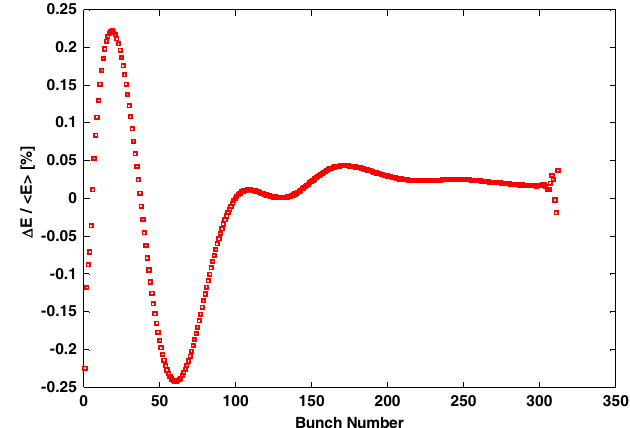
FIG. 7. Relative energy spread along the train for the analytical compensation pulse.